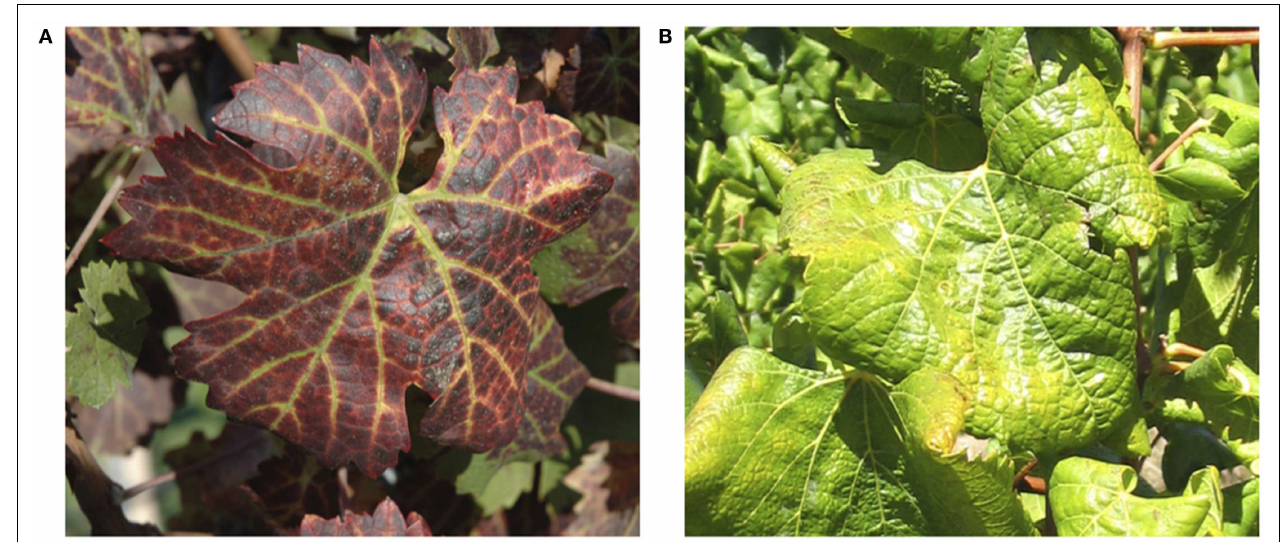
FIGURE 1 |Typical leafroll diseased vines: (A) a red cultivar, Vitis vinifera cv Cabernet Franc; (B) a white cultivar, Vitis vinifera cv Chardonnay.